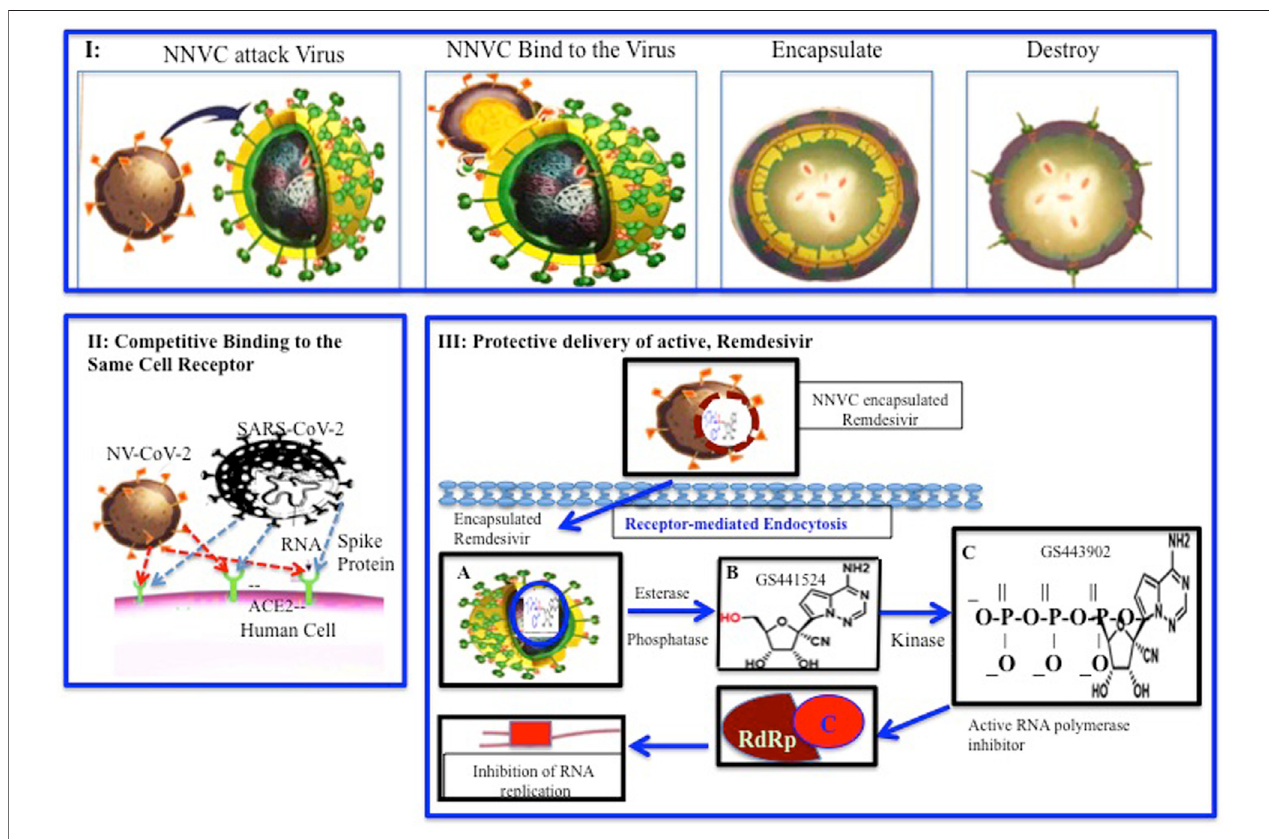
FIGURE 2 | Graphical representation of NV-CoV-2 action